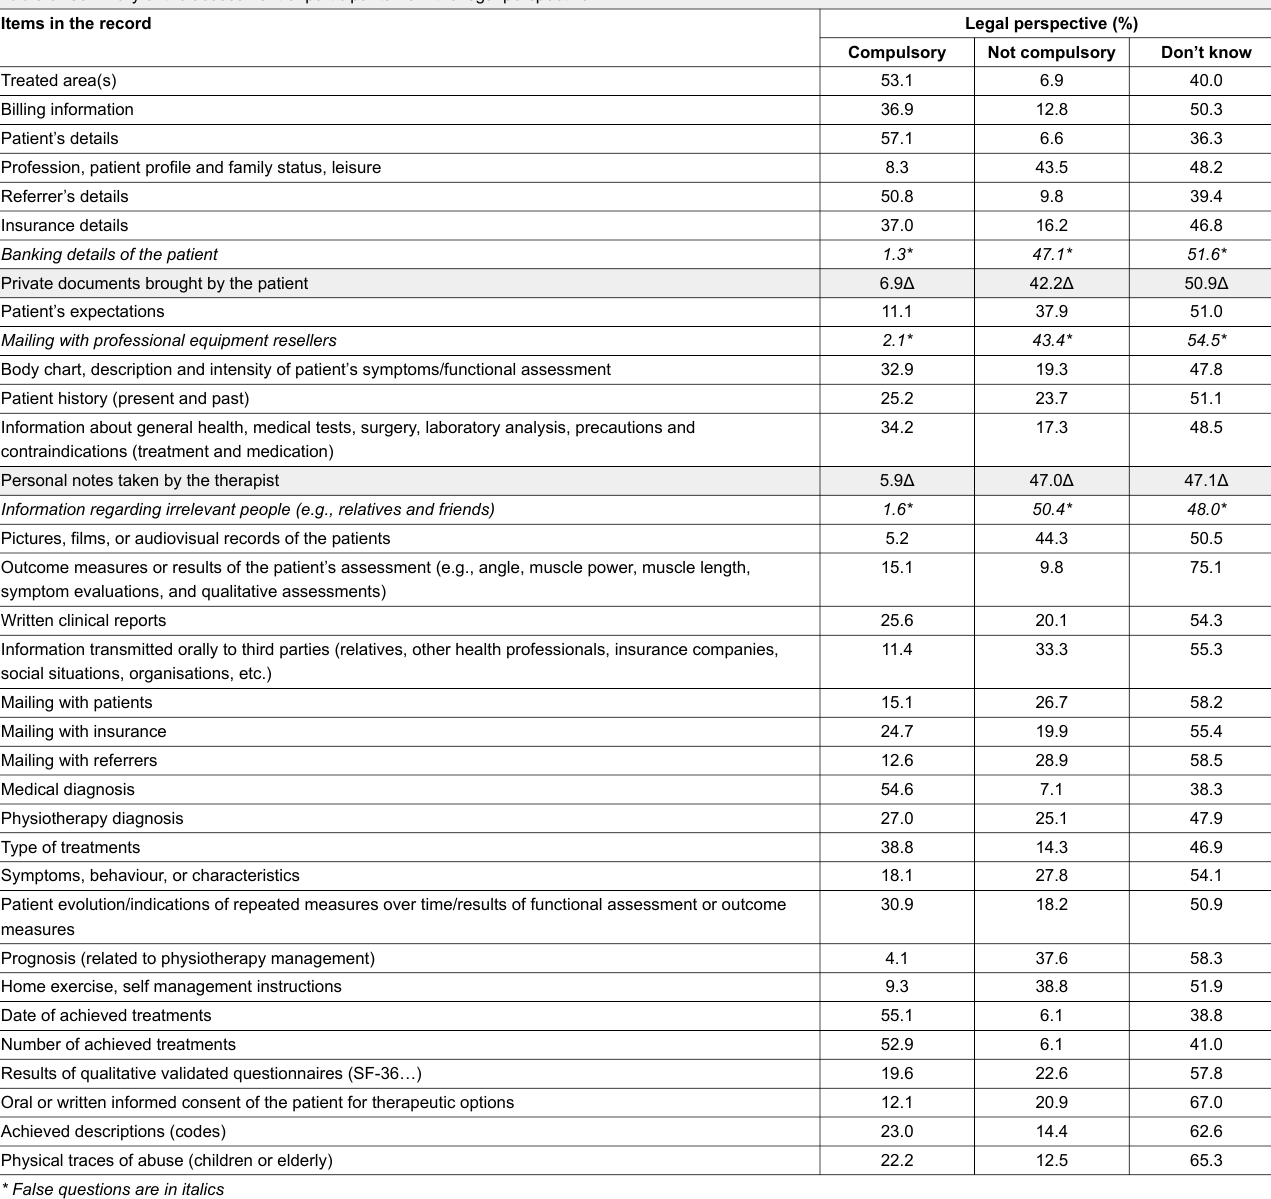
Table 3: Summary of the assessment of participants from the legal